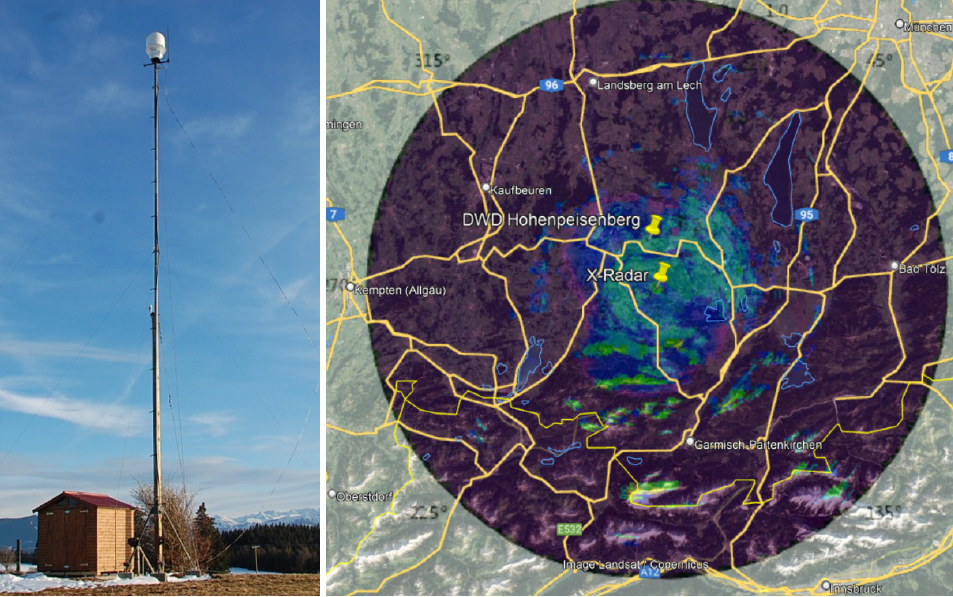
Figure 1. Image of X-Band radar, located in Kirnberg in southern Bavaria ( left ) and measurement radius. The pins indicate the location of the radar in the centre as well as the reference observation station at Hohenpeissenberg for validation ( right ).